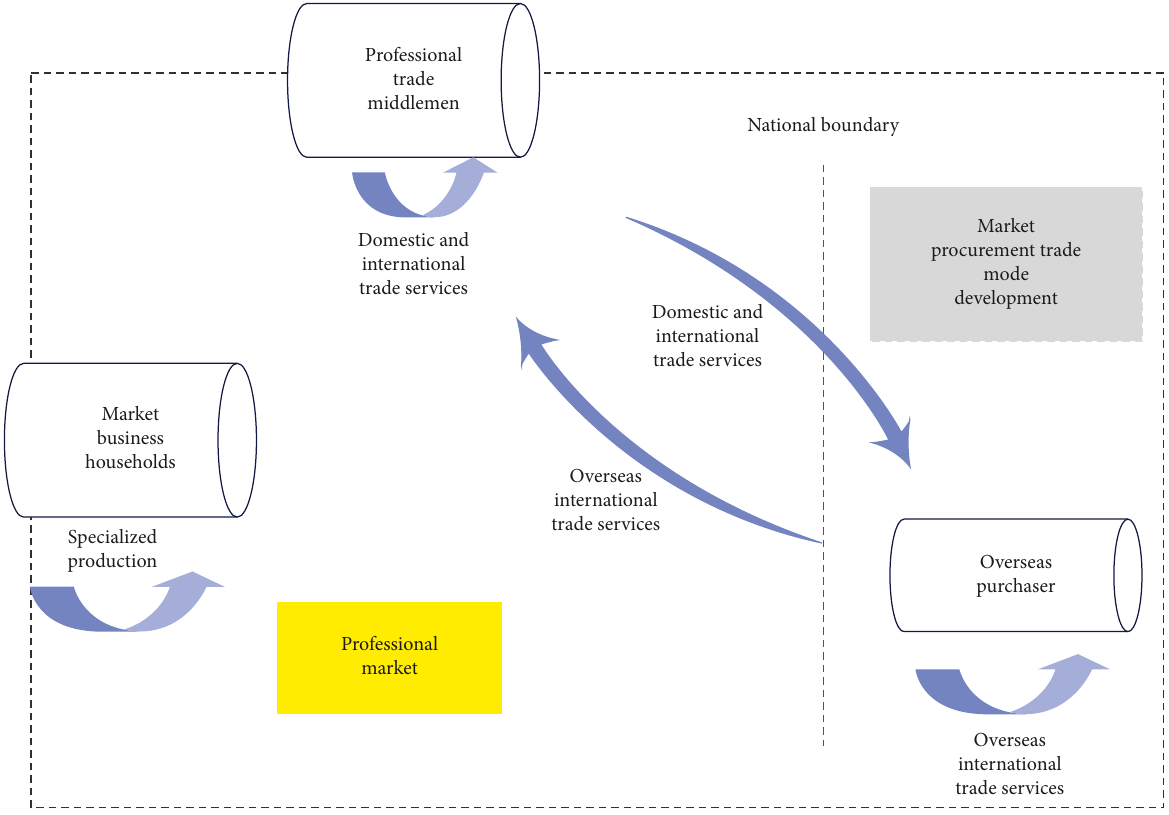
Figure 9: Formation period of purchasing and trade mode in small commodity